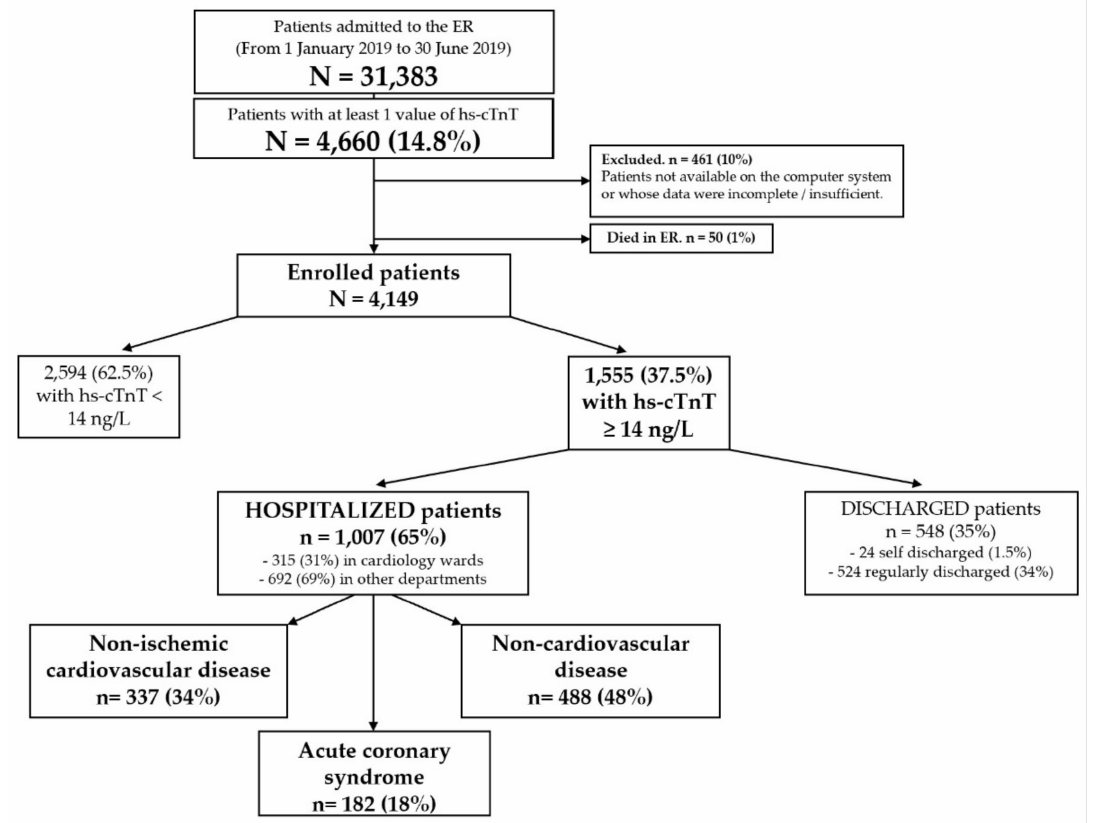
Figure 1. Flow-chart of the enrolled